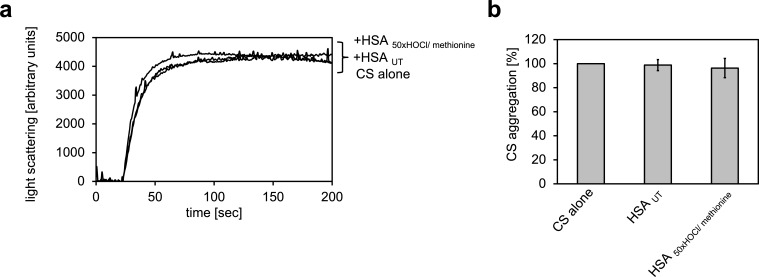
Serum albumin, when treated with a 50-fold molar excess of HOCl and then reduced with methionine, loses its propensity to decrease aggregation of chemically denatured citrate synthase.(a) Representative measurements are shown. (b) Data represented as means and standard deviations from three independent experiments. Aggregation of citrate synthase in the absence of HSA was set to 100% and all the data are presented as percentage of this control. Labels of aggregation curves are written in the order of the final intensity of light scattering of the respective treatment.
10.7554/eLife.47395.008Figure 2—figure supplement 2—source data 1.Numerical light scattering data obtained during protein aggregation assays represented in Figure 2—figure supplement 2.